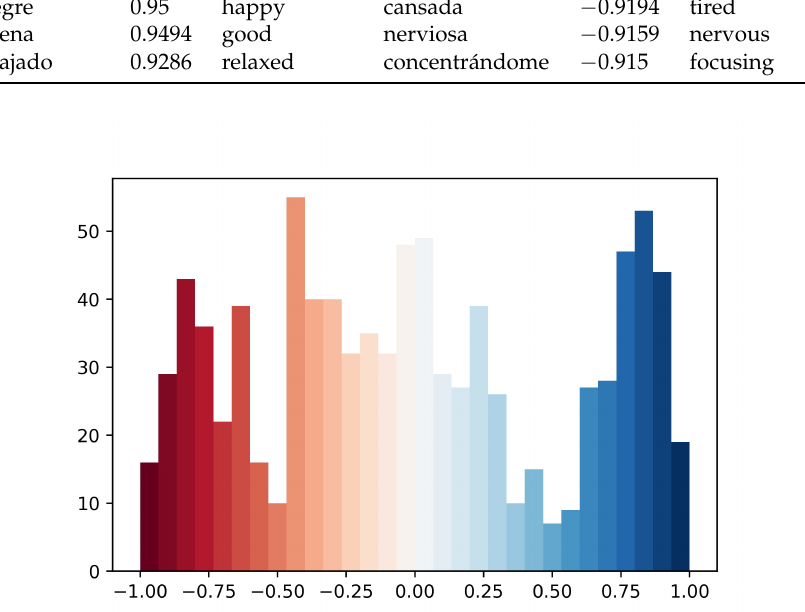
Figure 7. Histogram of the non-zero scores of words in the corpus. The colors are related to the